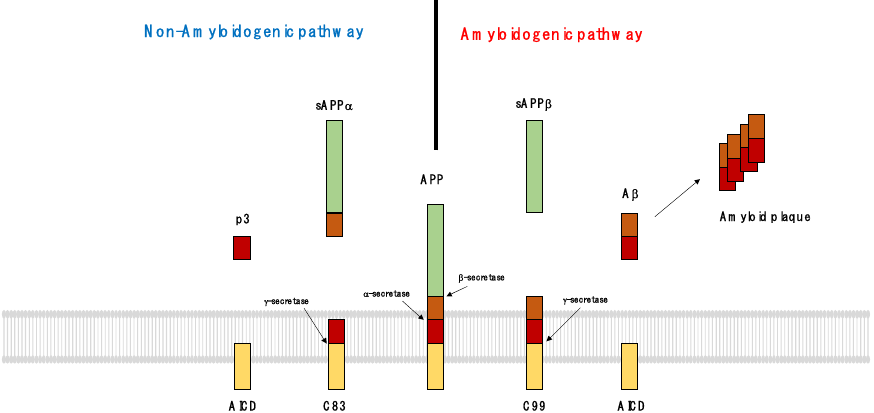
Figure 2. Non-Amyloidogenic and Amyloidogenic pathways of APP. In the non-amyloidogenic pathway, α-secretase cleavage of the Aβ region produces sAPPα and C83 fragments, and then γ- secretase cleavage of C83 produces p3 and AICD fragments which precludes Aβ formation. In the amyloidogenic pathway, cleavage of the Aβ region produces sAPPβ and C99 fragments. Then, the C99 fragment is cleaved by the γ-secretase complex into Aβ and AICD fragments. Accumulation of Aβs in the tissue forms plaque.